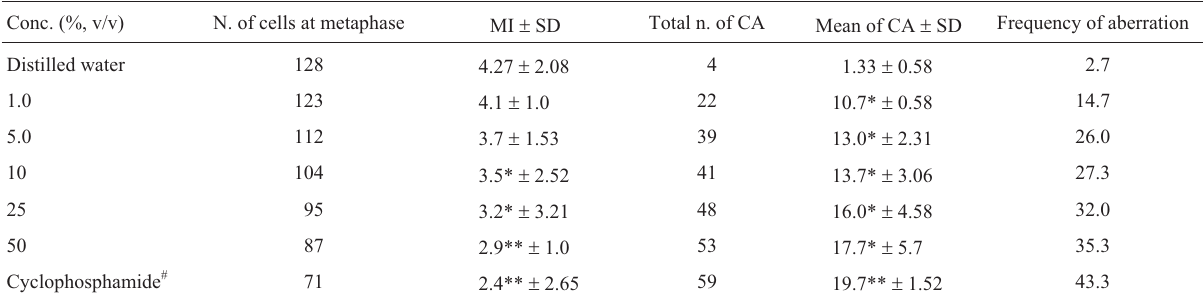
Table 3 - Chromosome aberrations (CAs) induced in bone marrow cells of mice exposed to different concentrations of the pharmaceutical effluent. Conc. (%, v/v) N. of cells at metaphase MI (cid:2) SD